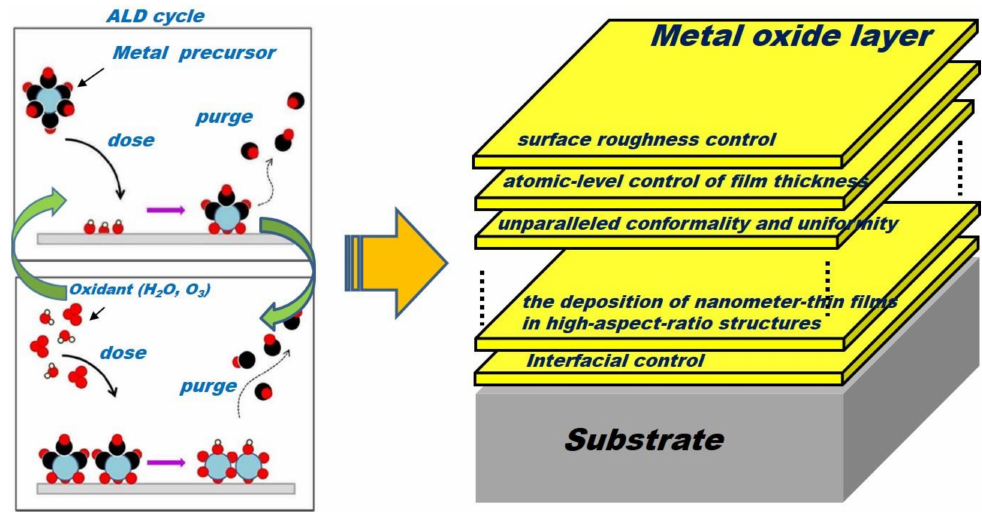
Figure 2. The schematic of atomic layer deposition (ALD) process and ALD characteristics.